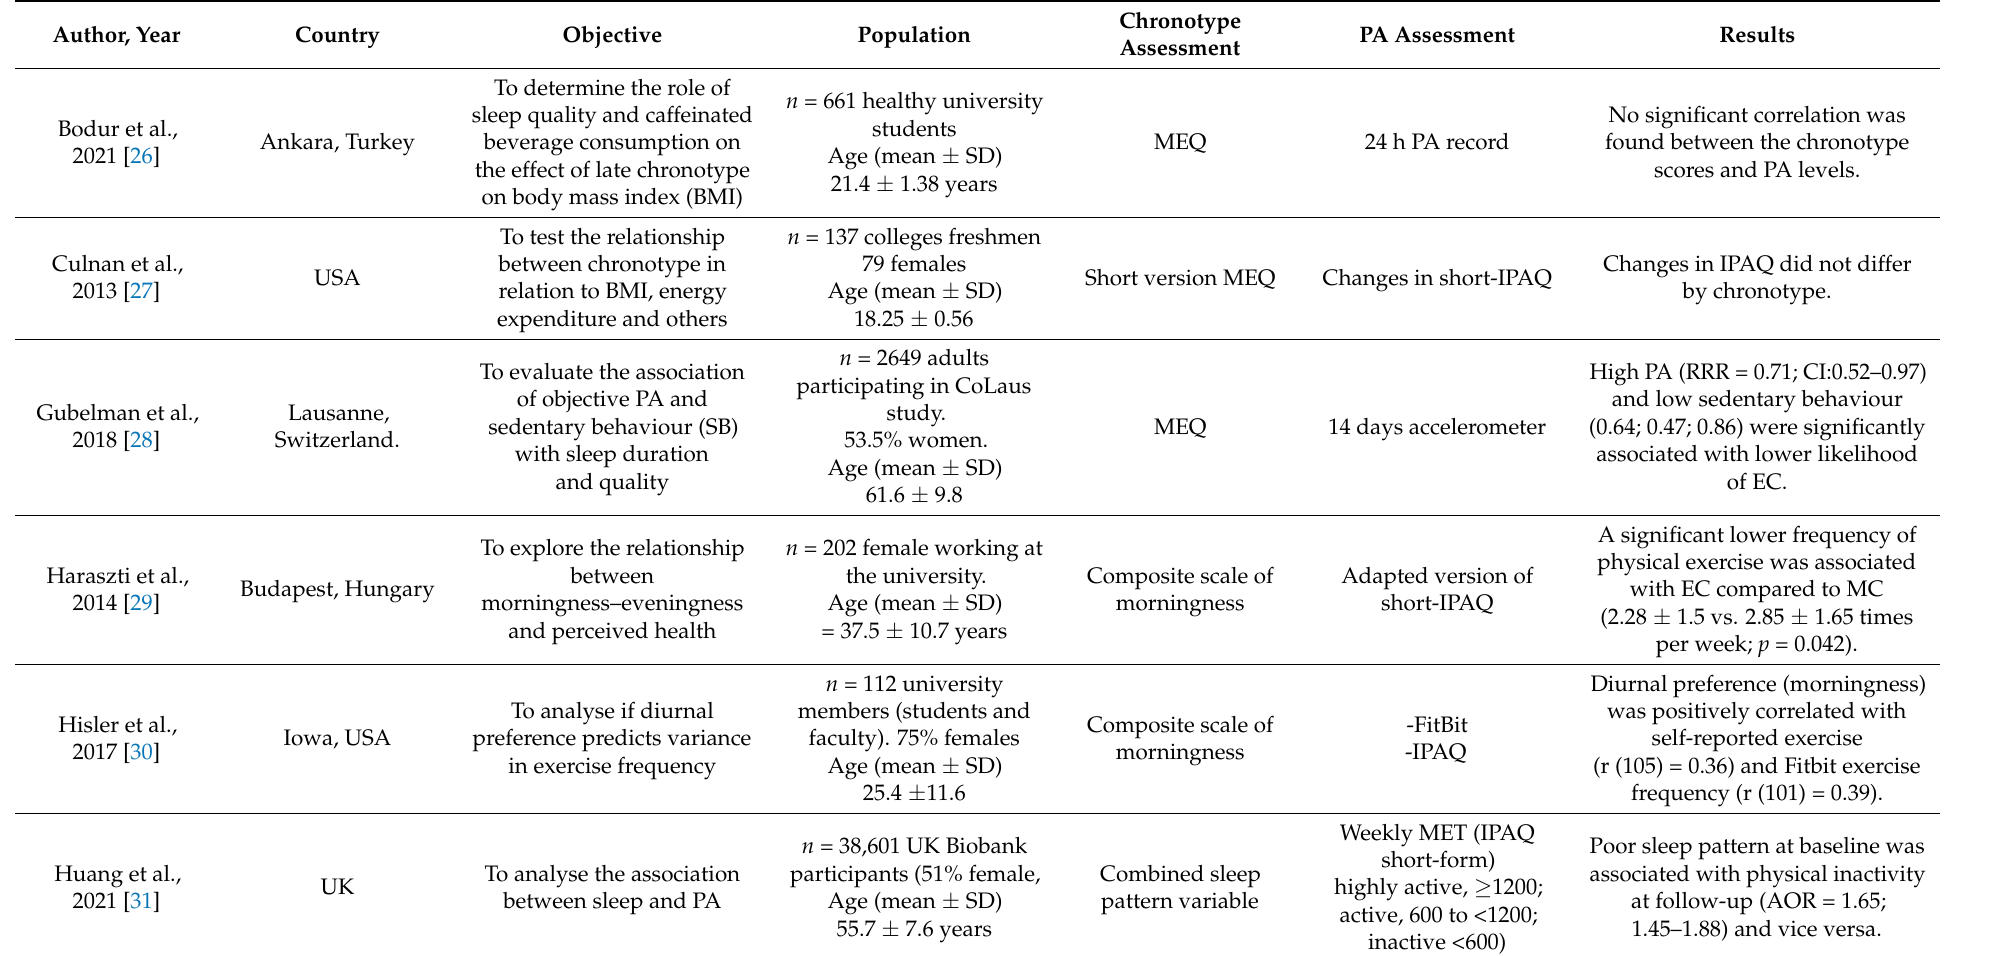
Table 1. Descriptive characteristics of the included studies on healthy